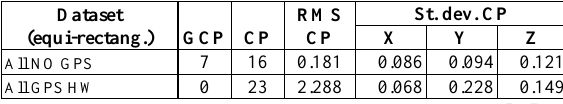
Table 8. Equirectangular dataset: stats on residuals [m].